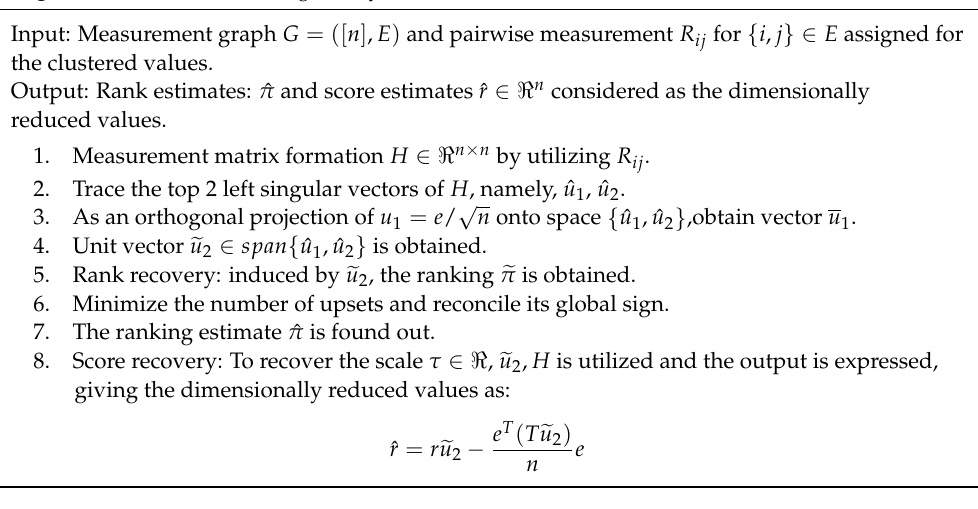
Algorithm 3 : SVD for ranking and